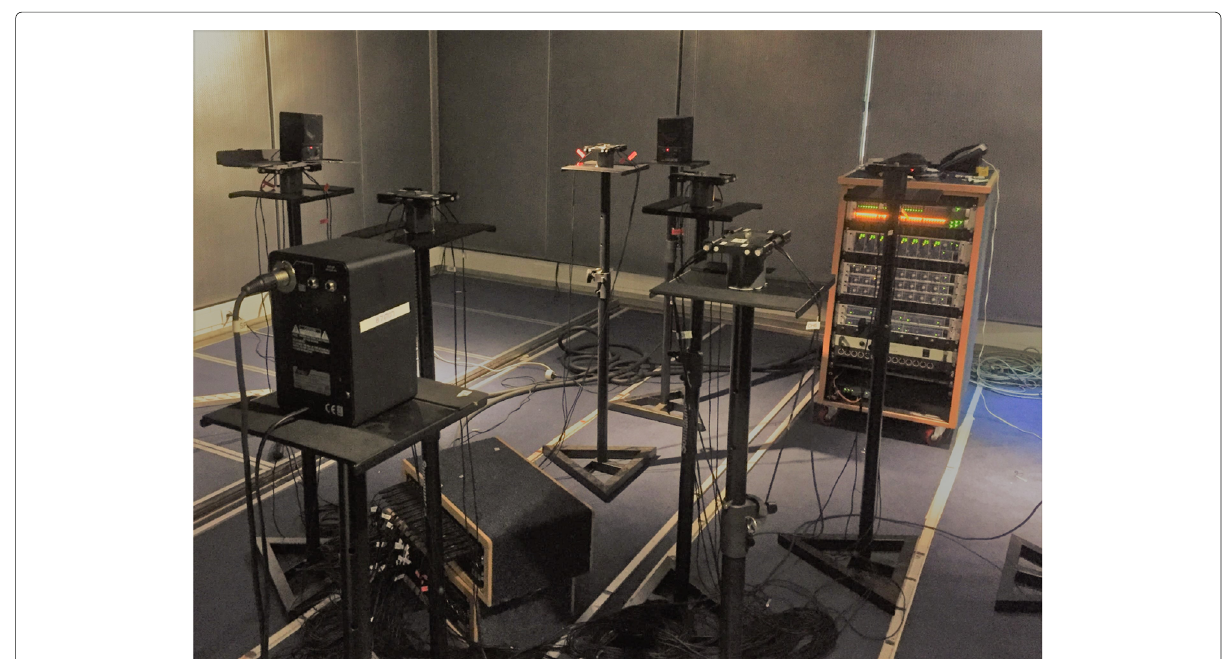
Fig. 2 Room setup example: loudspeakers, microphone arrays, and recording